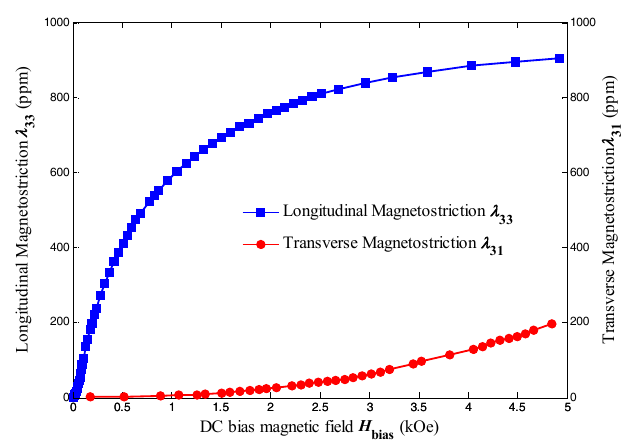
Figure 6. The longitudinal magnetostriction λ 33 and transverse magnetostriction λ 31 of Terfenol-D as a function of the DC bias magnetic field H bias at room temperature.